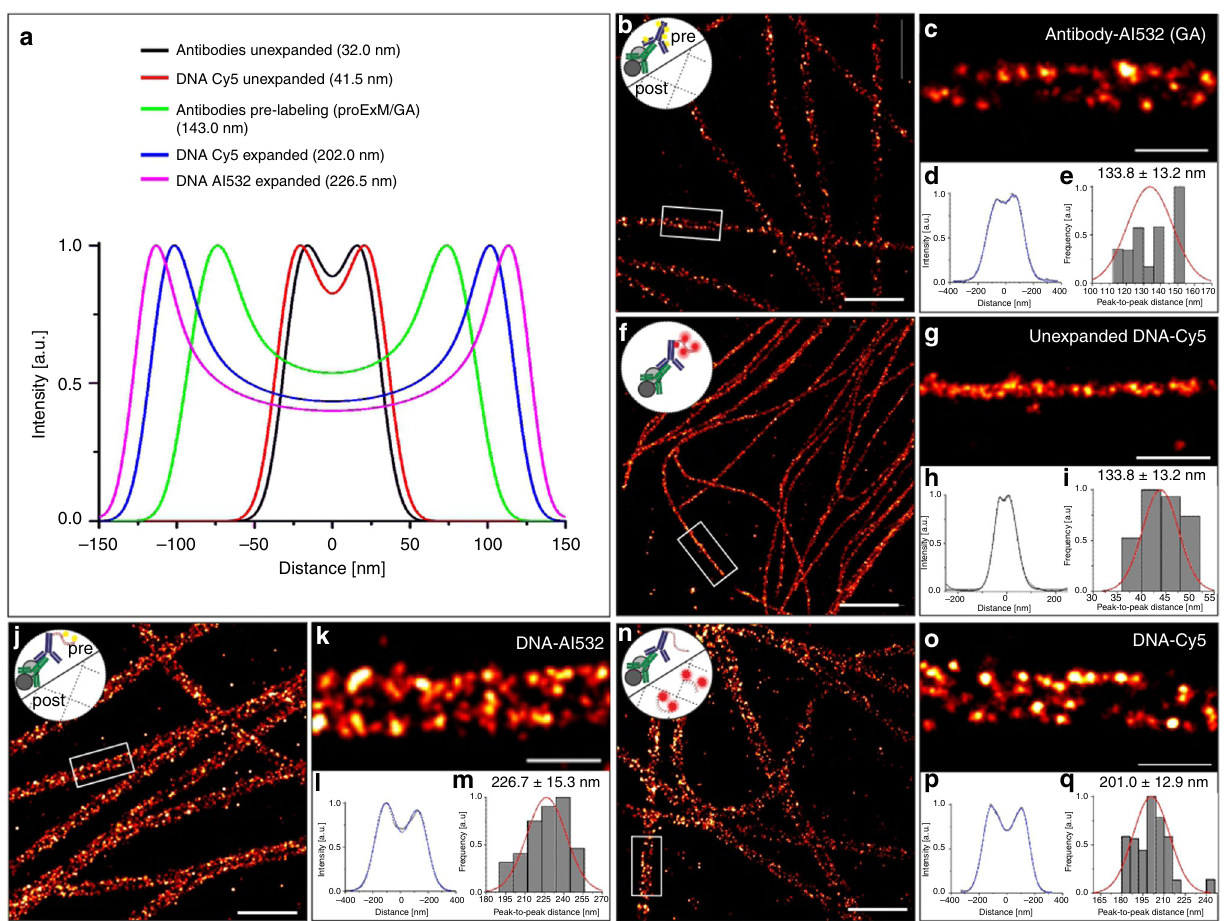
Fig. 2 Pre-labeling Ex- d STORM. a Simulated intensity pro fi les using a cylindrical distribution function to describe unexpanded or 3.2x expanded immunostained microtubules (labeled with IgG antibodies or DNA modi fi ed IgG antibodies pre-expansion) and resulting peak-to-peak distances of the cross-sectional pro fi les. b d STORM image of expanded and re-embedded α - and β -tubulin pre-labeled with secondary Alexa Fluor 532 IgG antibodies (Al532) using the MA-NHS/GA method 6 , i.e. antibodies are cross-linked with glutaraldehyde (GA) into the hydrogel (Antibody-Al532 (GA)). c Zoom in of white boxed region in ( b ). d Averaged cross-sectional pro fi le of 8 microtubule segments with a length between 1.5 – 6.4 µ m and 28.6 µ m in total measured in 4 expanded cells. e Histogram of peak-to-peak distance distribution with normalized normal curve (red) of microtubule segments analyzed in ( d ) at n = 8 microtubule segments in 4 cells from 1 expansion experiment with a mean distance of 133.8 ± 13.2 nm (mean ± sd). f Unexpanded d STORM image of ssDNA-Cy5 secondary antibody hybridized with Cy5 bearing oligonucleotides pre-expansion (DNA-Cy5 protocol). g Magni fi ed view of white boxed region in ( f ). h Average cross-sectional pro fi le of 7 microtubule segments with a length between 1.0 – 1.8 µ m and 8.7 µ m in total. i Histogram of peak-to-peak distances with normalized normal distribution curve (red) of the data analyzed in ( h ) along n = 7 microtubule segments in 2 cells from 1 experiment with a mean distance of 43.9 ± 3.7 nm (mean ± sd). j Expanded d STORM image of microtubules labeled with α -tubulin and dsDNA (DNA-Al532) conjugated secondary antibodies exhibiting a methacryloyl group to crosslink the DNA with fl uorophores pre-expansion into the hydrogel (original ExM trifunctional label concept) 1 . k Zoom-in of white boxed region in ( j ). l Average intensity pro fi le of 26 microtubule segments with a length of 2.4 – 10.7 µ m and 118.6 µ m in total. m Histogram of peak-to-peak distances with normalized normal distribution curve (red) determined from n = 26 microtubule segments in 4 cells from 1 expanded sample showing a mean distance of 226.7± 15.3 nm (mean ± sd). n d STORM image of α - and β -tubulin expanded according to the DNA- Cy5 protocol strategy with labels at Cy5-bearing oligonucleotides introduced post-re-embedding. o Zoom in of white boxed region in ( n ). p Average intensity pro fi le of 15 microtubule segments with a length between 1.6 – 25.1 µ m and a total length of 126.0 µ m in 1 expanded sample. q Histogram of peak- to-peak distances with normalized normal distribution curve (red) determined by fi tting the cross-sectional pro fi les analyzed in ( p ) along n = 22 microtubule segments in 4 cells from 1 expanded sample showing a mean distance of 201.0 ± 12.9 nm (mean ± sd). The small logos in the upper left corner symbolize the labeling method, e.g. pre- and post-immunolabeled with or without DNA-linker, respectively. Scale bars, 2 µ m ( b , f , j , n ), 500 nm ( c , g , k , o